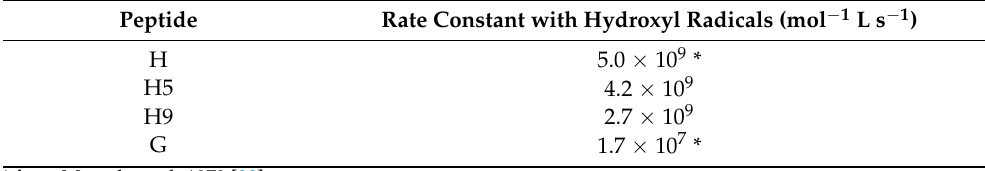
Table 3. Rate constants of peptides with OH radicals in water as evaluated by the KSCN method.